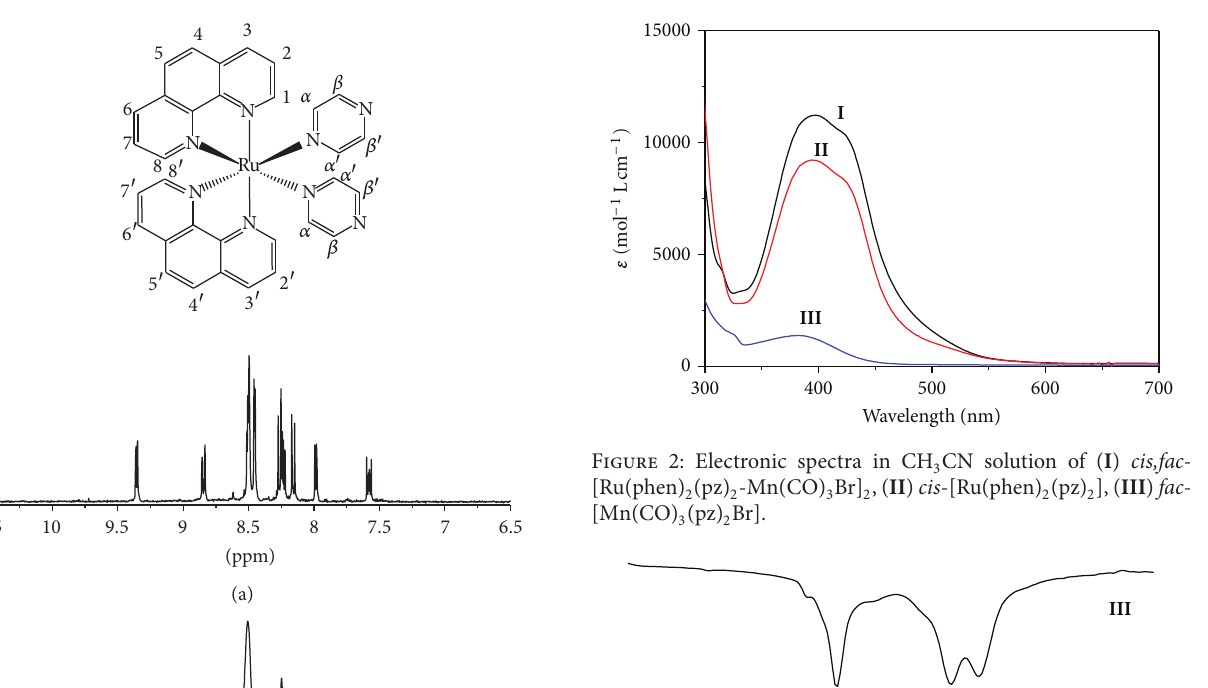
CN of the aromatic region to the 3